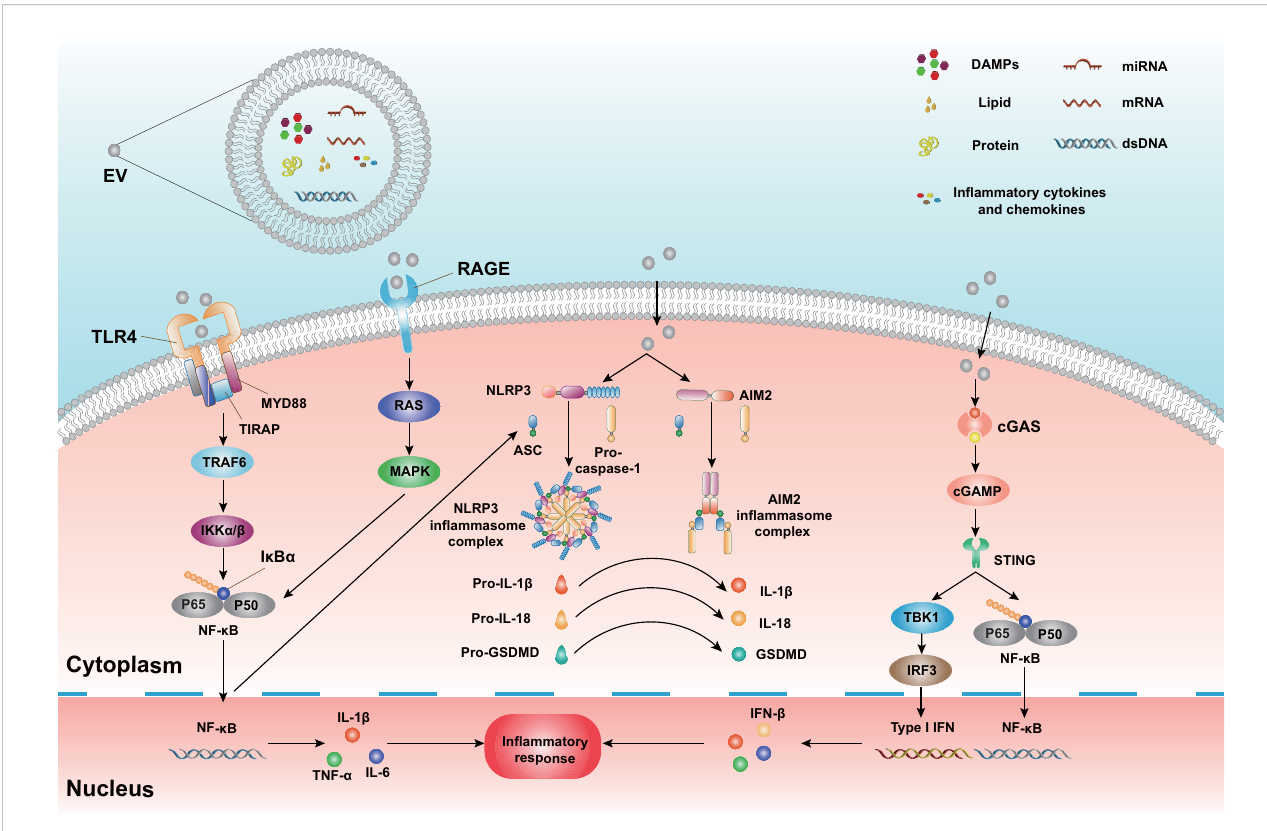
FIGURE 2 The mechanism of neuroin fl ammatory modulation by EVs and cargo. EVs carry distinct biomolecules, including nucleic acids (DNA and multiple RNA types), proteins, lipids, DAMPs, cytokines, and chemokines. These cargoes interact with relevant receptors and ultimately lead to an in fl ammatory response in recipient cells. EVs bind to TLRs and initiate the activation of the downstream signaling proteins MyD88, TIRAP, TRAF6, and I k B a . In addition, EVs bind to RAGE and activate the Ras and MAPK pathways. These pathways subsequently trigger the activation of downstream NF- k B and generation of pro-in fl ammatory cytokines (IL-1 b , TNF- a , IL-6). During TBI, EVs interact with NLRP3 and AIM2 in fl ammasomes and promote the activation of caspase-1. Activated caspase-1 cleaves pro-IL-1 b , pro-IL-18, and pro-GSDMD, resulting in pyroptosis and pro-in fl ammatory molecule release. Additionally, EVs release and carry dsDNA post-TBI. These EVs bind to cGAS and activate cGAMP and STING. Subsequently, STING triggers the TBK1, IRF3, and NF- k B pathways and ultimately leads to IFN-I transcription and in fl ammatory mediator release. DAMPs, Damage associated molecular patterns; TLRs, Toll-like receptors; MyD88, Myeloid differentiation factor 88; TIRPAP, Toll-interleukin 1 receptor domain-containing adaptor protein; TRAF6, TNF receptor- associated factor 6; I k B a , inhibitor of NF-kB; RAGE, The receptor for advanced glycation end products; MAPK, Mitogen-activated protein kinase; NF- k B, Nuclear factor k -light chain-enhancer of activated B cells; NLRP3, Nucleotide oligomerization-like receptor protein 3; AIM2, absent in melanoma 2; GSDMD, Gasdermin-D; cGAS, the cyclic GMP-AMP synthase; cGAMP, cyclic dinucleotide (CDN)-2 ′ ,3 ′ -cyclic guanosine monophosphate-adenosine monophosphate; STING, stimulator of interferon genes; TBK1, TANK-binding kinase 1; IRF3, Interferon regulatory factor 3; IFN-I, type I